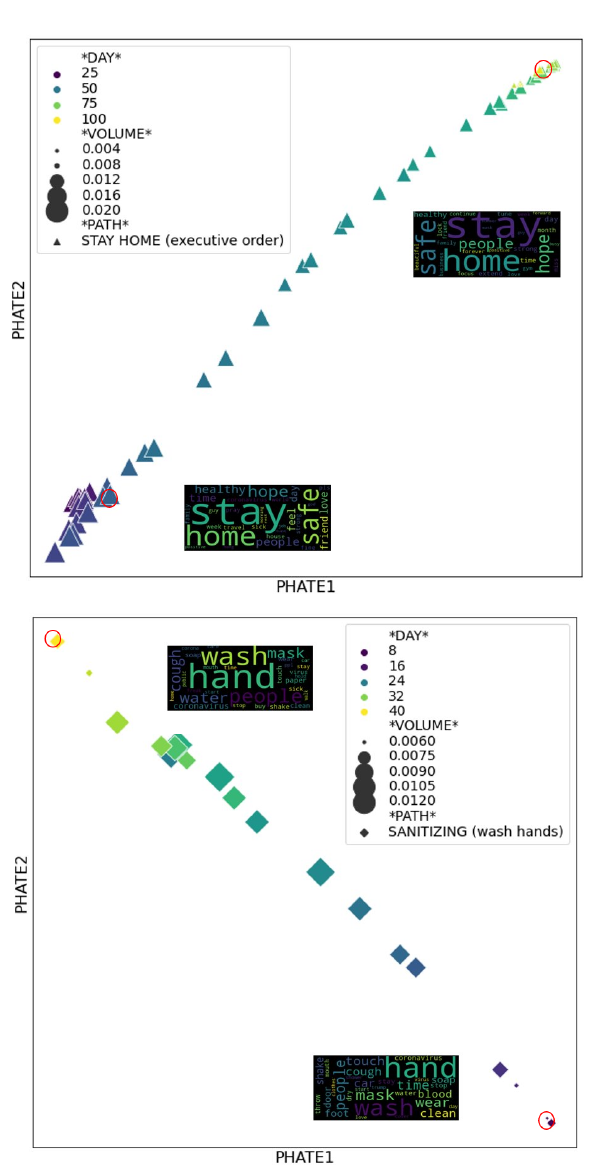
Figure J.1. Potential of heat-diffusion for affinity-based transition embedding (PHATE) for subsets of topics lie on the executive order path (top) and the wash hands path (bottom). Colors and sizes of points highlight time and tweet volume, respectively. Here two word clouds containing top 30 words in corresponding topics are shown for the time points highlighted by red circles in each path. Note that in both cases, the topic near the beginning of the study period is similar to that near the end of the study period. This shows the stability of topics on linear